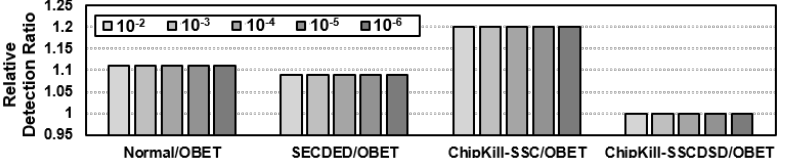
Figure 6. Error detection rates are significantly increased with the support of OBET on various bit-error rates